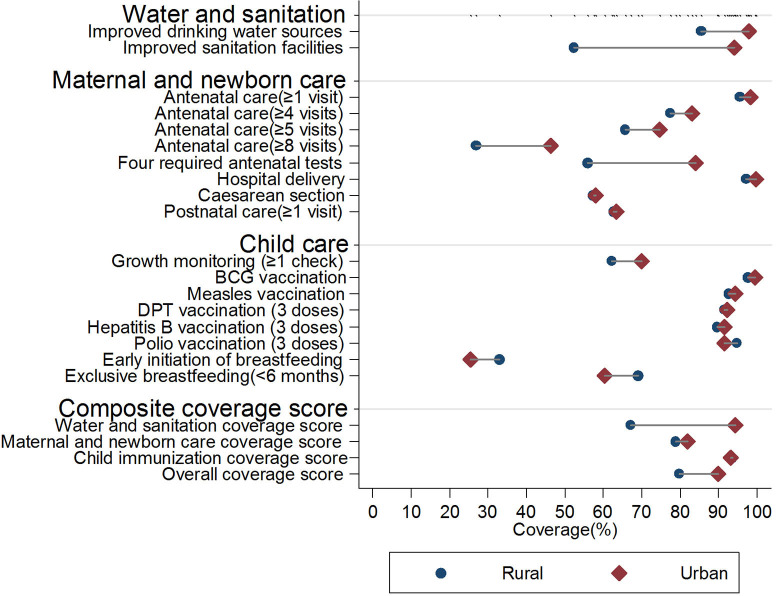
Equity gaps between rural and urban settings in essential MNCH interventions, Jilin province, China (2008–2018). For details of the regression results for each specific intervention, please see Appendix 4.
In the water and sanitation domain, the interventions were adjusted for setting, household economic status, time to the nearest health facility, household head educational achievement, health insurance coverage, and ethnicity.In the maternal and newborn domain, the interventions were adjusted for setting, household economic status, time to the nearest health facility, mother's educational achievement, health insurance coverage, age when giving birth, parity, and ethnicity.In the child care domain, the interventions were adjusted for setting, household economic status, household head educational achievement, time to the nearest health facility, children's health insurance, age in months, sex, and ethnicity.Hospital delivery and BCG vaccination were not adjusted because the proportions were near 100%.